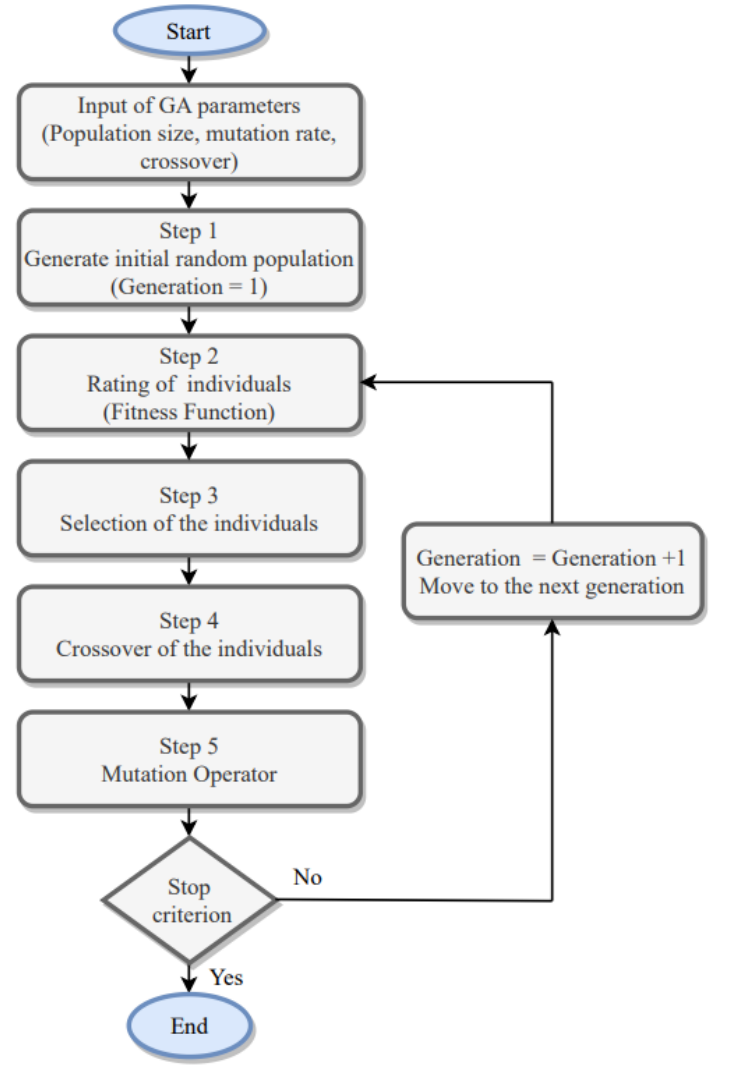
Figure 3. Flowchart of a Genetic Algorithm.